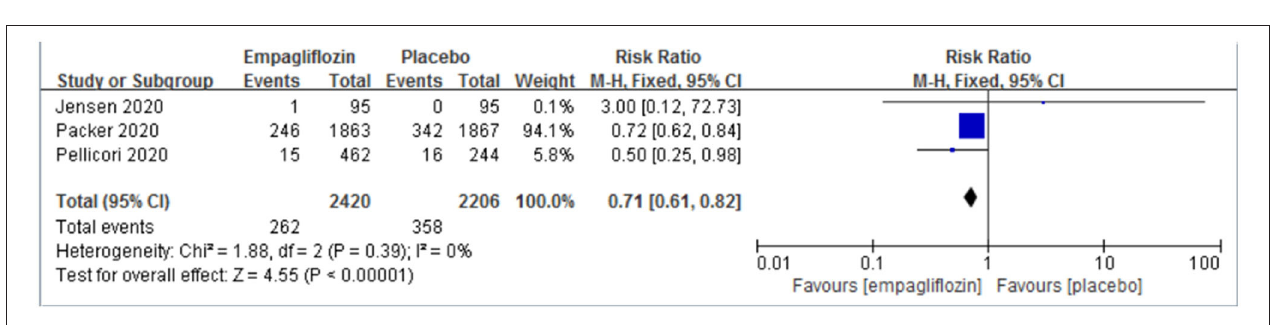
FIGURE 2 | Effect of empagliflozin on a composite of cardiovascular deaths or hospitalizations for worsening heart failure [ (A) by fixed-effects model; (B) by random-effects model].